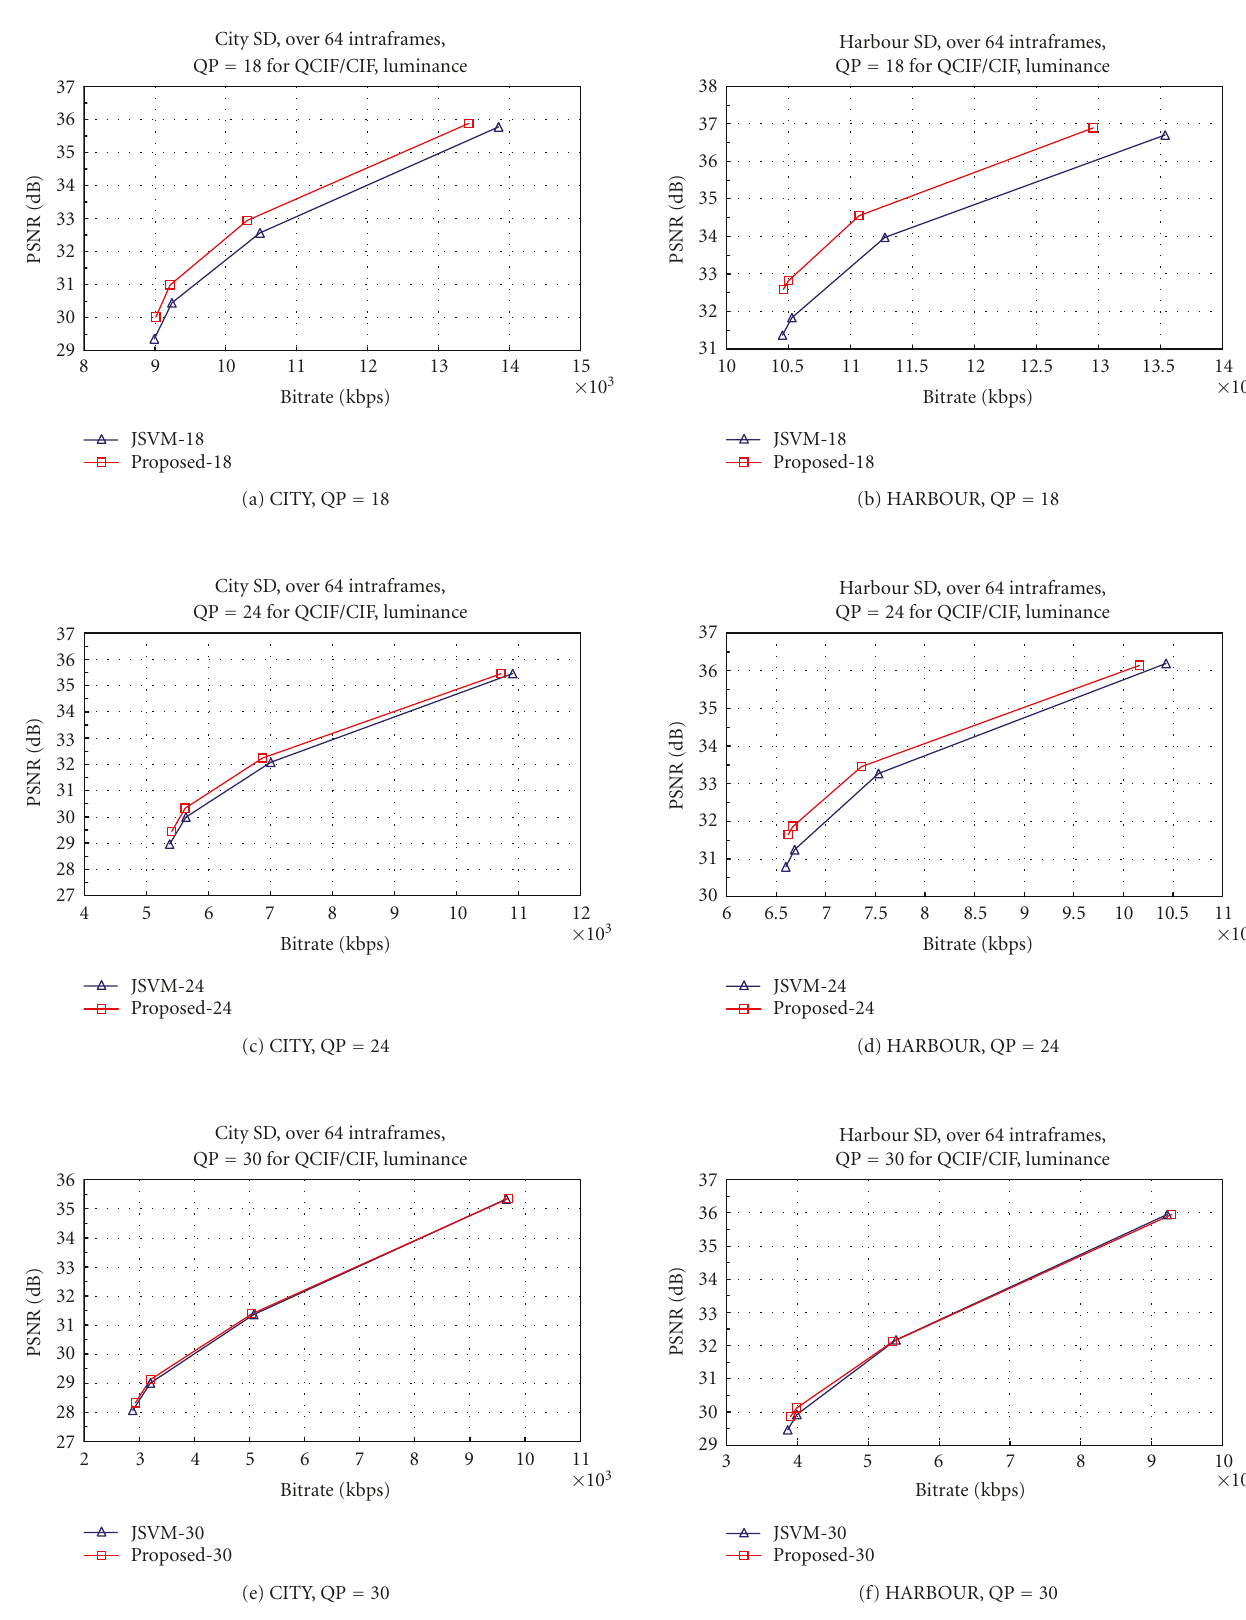
Figure 7: PSNR-rate curves for the luminance component of (a) CITY and (b) HARBOUR SD 30 Hz over 64 intraframes, when QPs for QCIF/CIF are 18, 24,